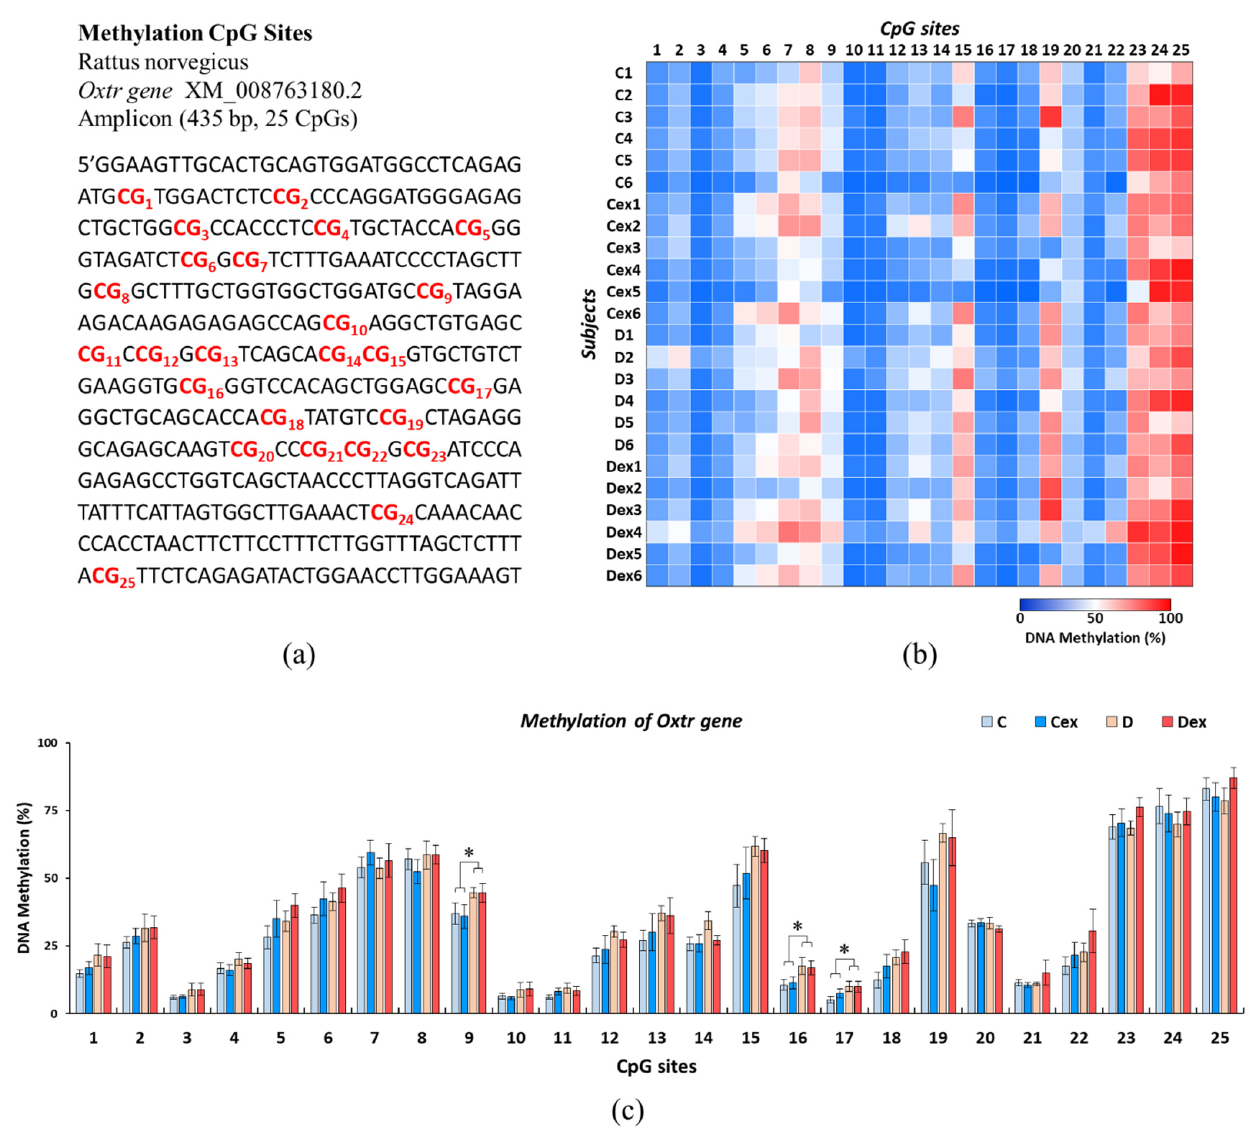
Figure 3 . Effects of prenatal DEHP exposure and childhood exercise on Oxtr methylation levels in postpartum dams. ( a ) Epigram of 25 CpG sites (red-coded) within the Oxtr promoter region. ( b ) Heatmap of methylation levels of observed animals. ( c ) Mean methylation levels across 25 CpG sites in the hypothalamic Oxtr gene. The analyzed results revealed that 3 out of 25 CpG sites were significantly hyper-methylated by the effect of DEHP, including CpG9, CpG16, and CpG17. Data are presented in mean ± SEM ( n = 6 in each group). *: p < 0.05.